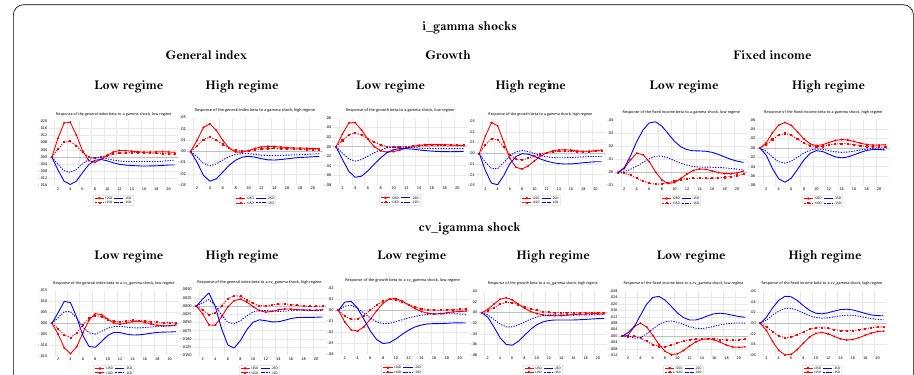
Fig. 12 Response of hedge fund beta to a moderate and strong negative and positive illiquidity shocks in low and high regimes for the general index and the fixed income and growth strategies. Notes: Liquidity shocks are measured by the main series of Pástor and Stambaugh (2003)—i.e., the innovation in aggregate liquidity ( i_gamma )—and its conditional variance as computed with the EGARCH (Nelson 1991) method ( cv_ igamma ). The plots correspond to the impulse response functions of strategies’ betas to liquidity shocks. They are built with the Balke (2000) nonlinear impulse response function algorithm using the generalized impulse response function to identify the structural shocks (Koop et al. 1996; Pesaran and Shin 1997, 1998). For